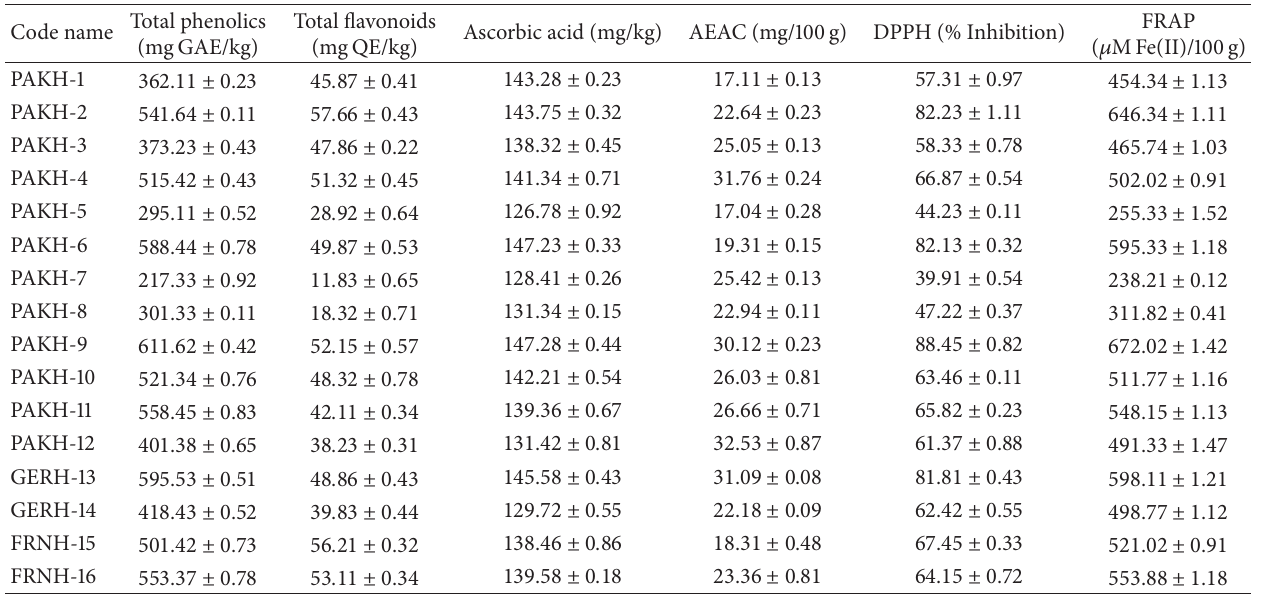
Table 3: Total phenolics, total flavonoids, ascorbic acid, AEAC, DPPH, and FRAP of sixteen honey samples produced in Pakistan and two other countries samples (mean ± SD, 𝑛 = 3